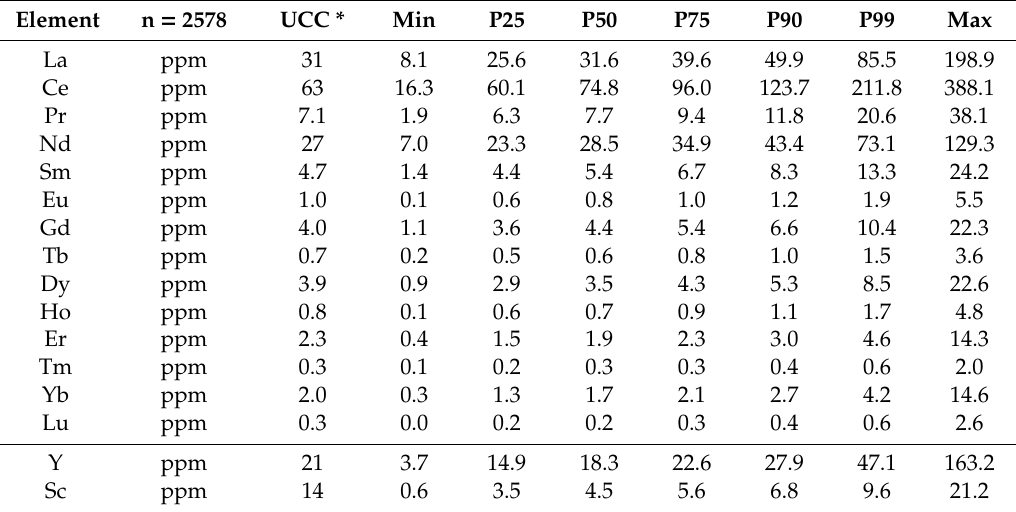
Table 4. Percentiles, minimum, and maximum values for the REE + Y + Sc from the till dataset. P50 is a median value. * abundance in the upper continental crust